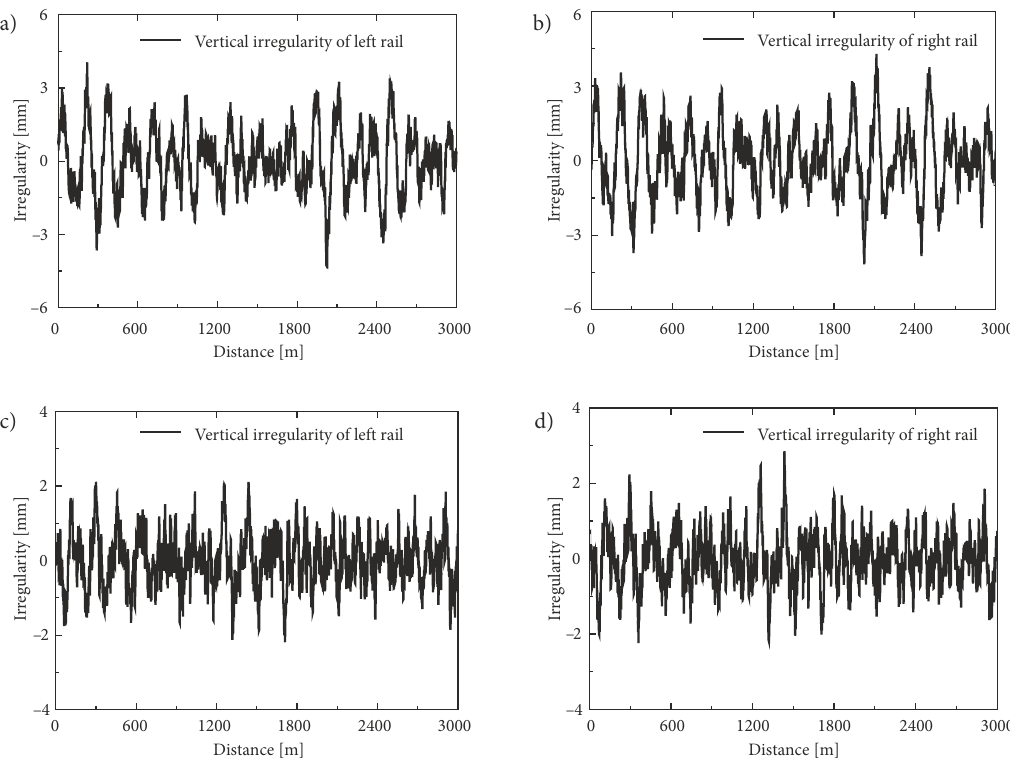
Figure 3. Vertical and alignment irregularities of the selected track: a – alignment irregularities of left rail; b – alignment irregularities of right rail; c – vertical irregularities of left rail; d – vertical irregularities of right rail